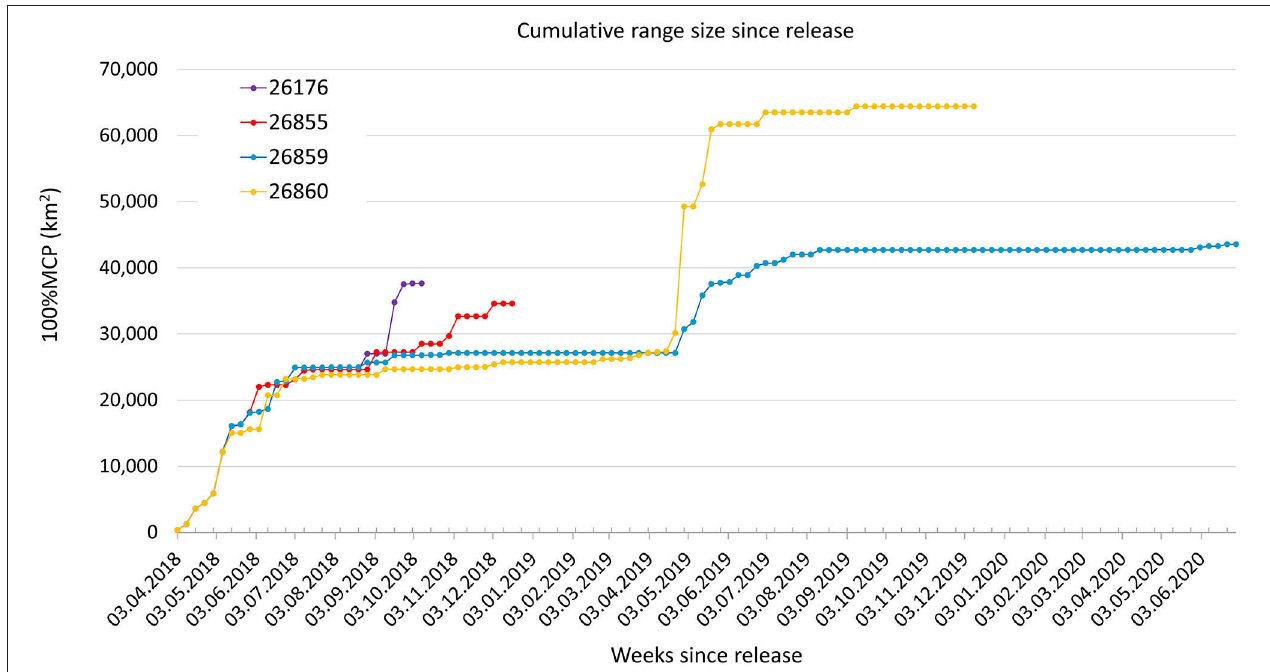
FIGURE 7 | Range size development of reintroduced kulan in the Torgai region since release. MCP100% were re-calculated at weekly